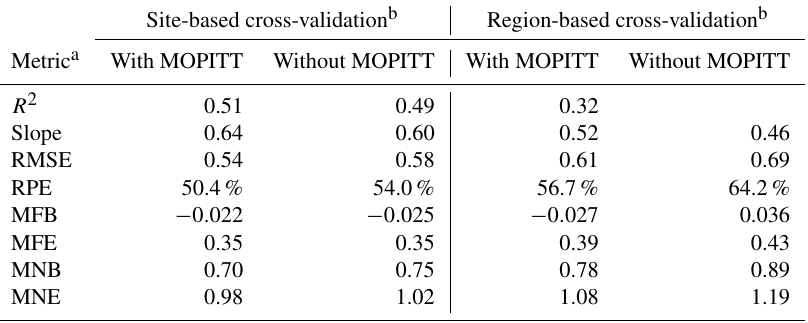
Table 2. Performance comparisons of the RF–STK models with and without MOPITT data in predicting daily ground-level CO concentra- tions across China during 2013–2016.